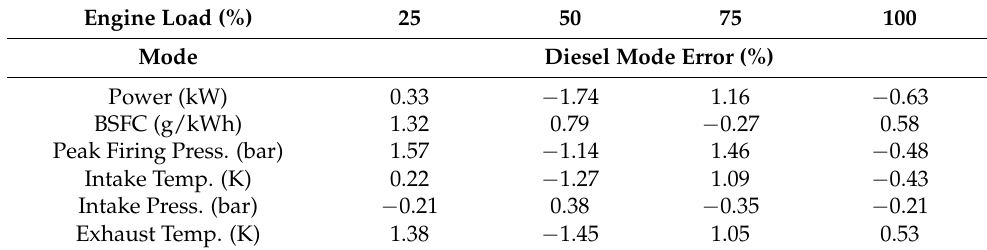
Table 3. Calculation errors of the parameters in diesel mode.